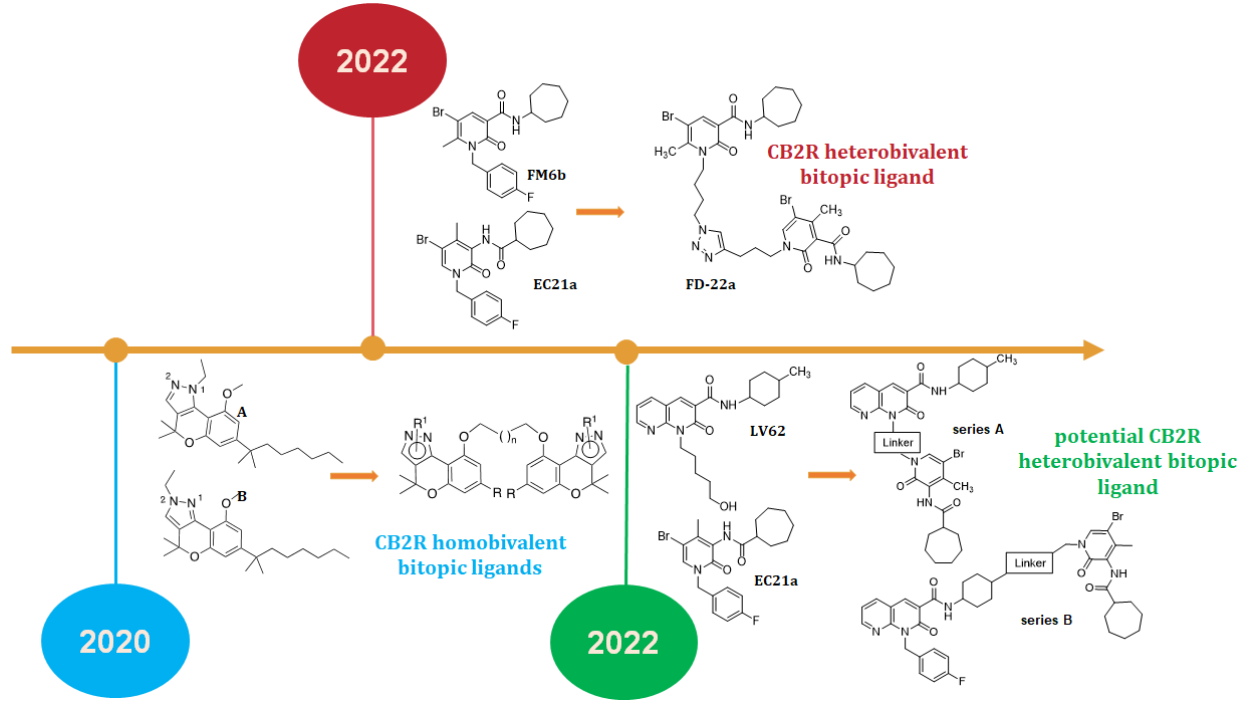
Figure 1. Timeline of published studies about CB2R bitopic (dualsteric)